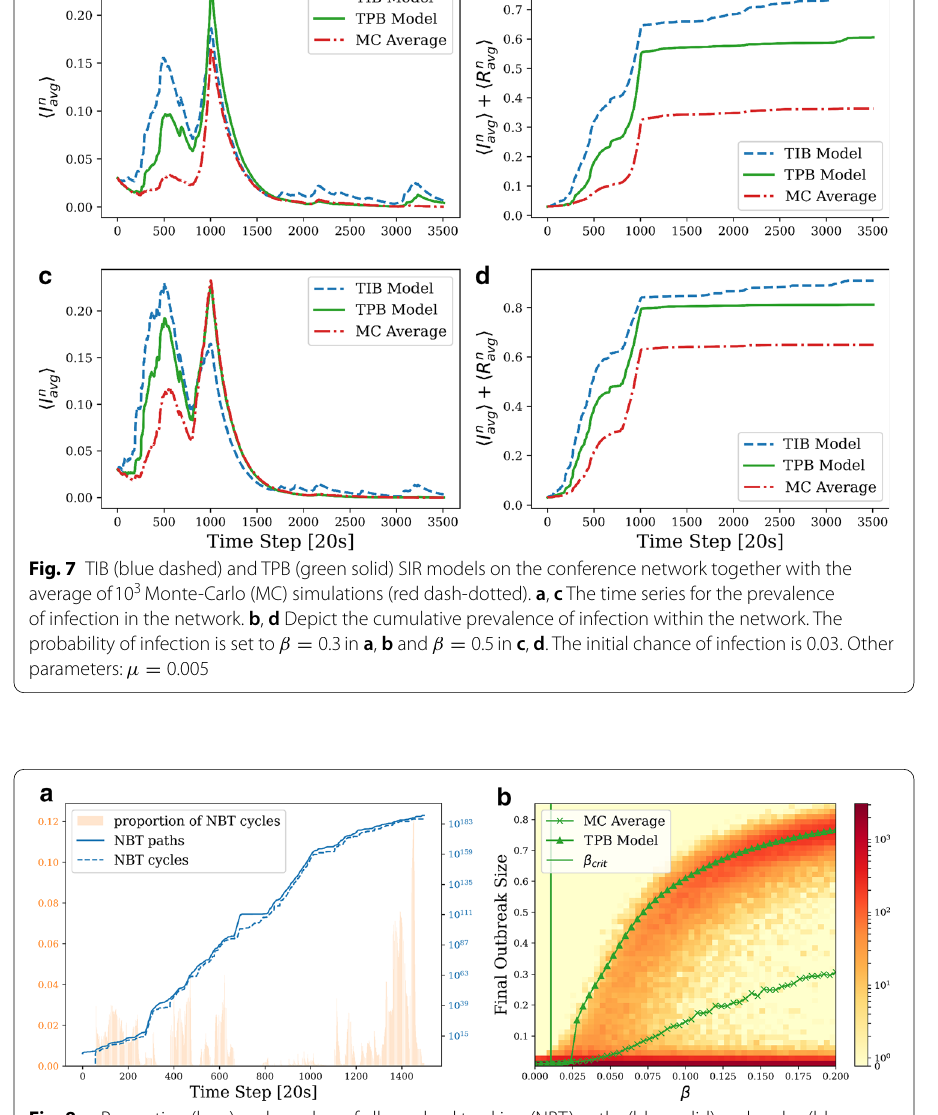
Fig. 8 a Proportion (bars) and number of all non-backtracking (NBT) paths (blue solid) and cycles (blue dashed) that close at each respective time step. b Final outbreak sizes for varying values of β with µ =